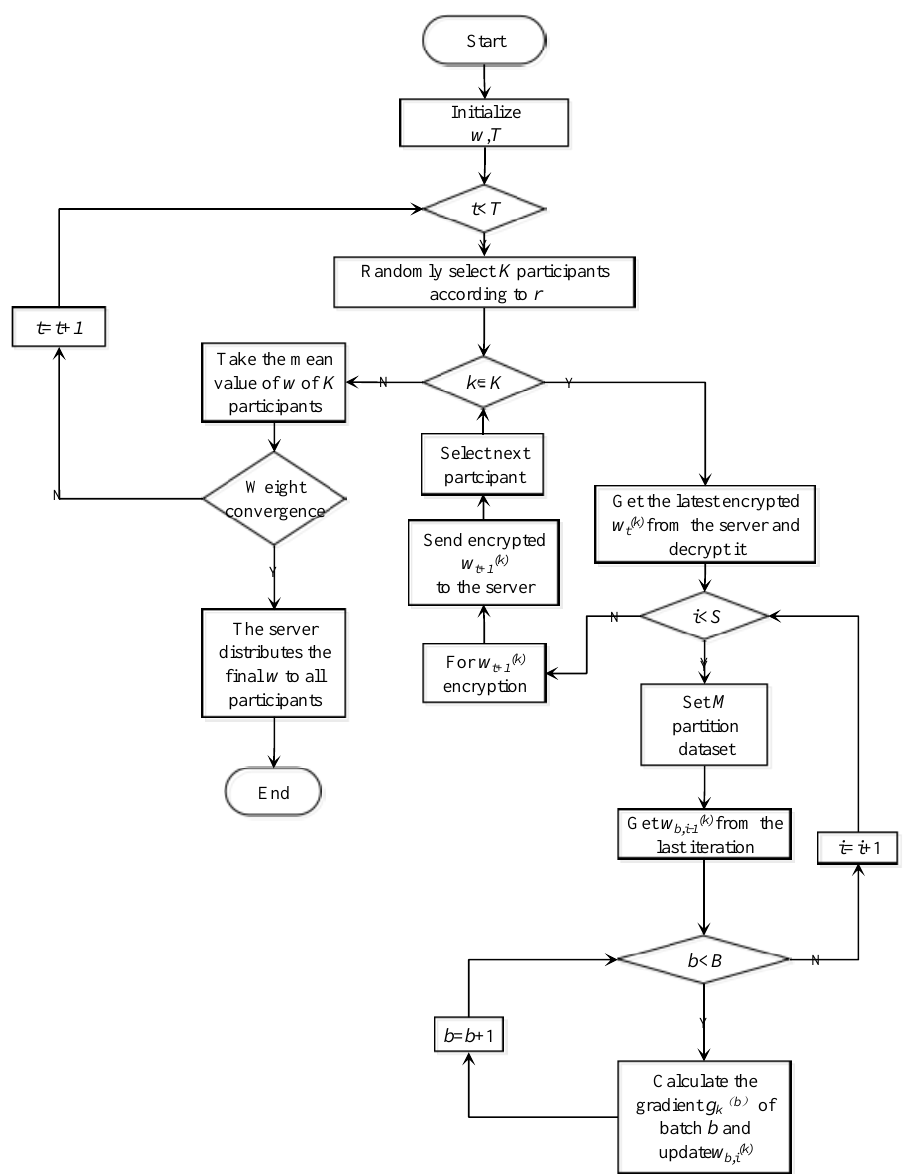
Figure 3. Horizontal federation learning client – server architecture.